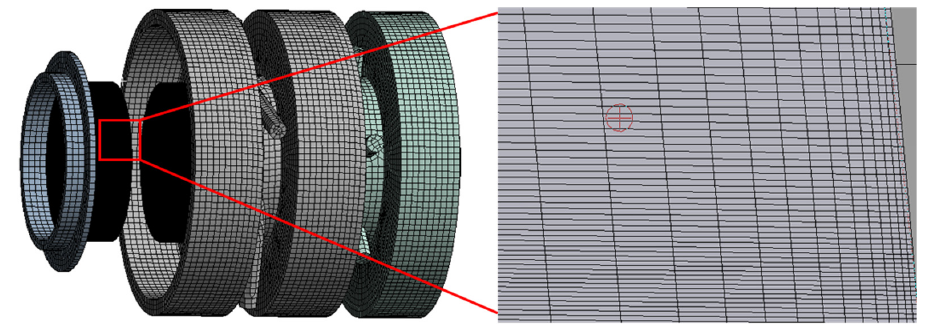
Figure 6. Fluid domain meshing.